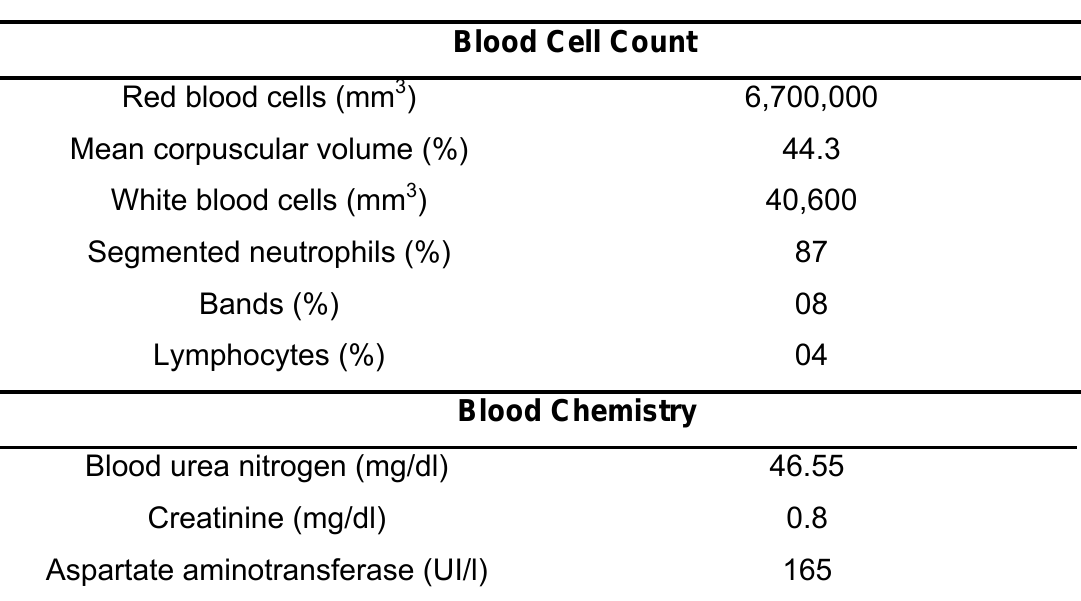
Table 1. Abnormalities in blood cell count and blood chemistry 24 hours after Crotalus envenomation.